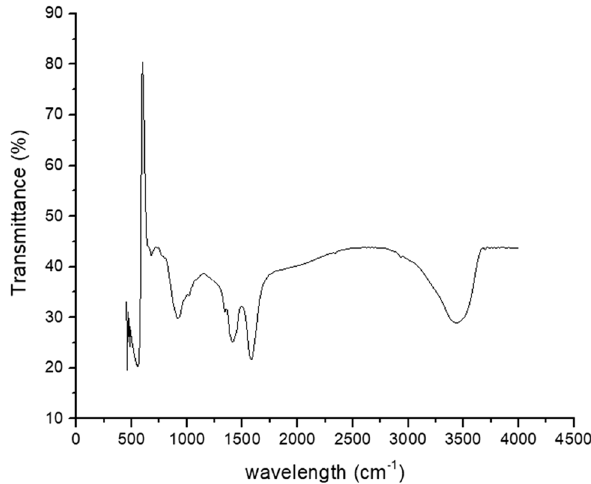
Fig. 6 FTIR Spectroscopy ofsynthesize ZnO Nanopar- ticles